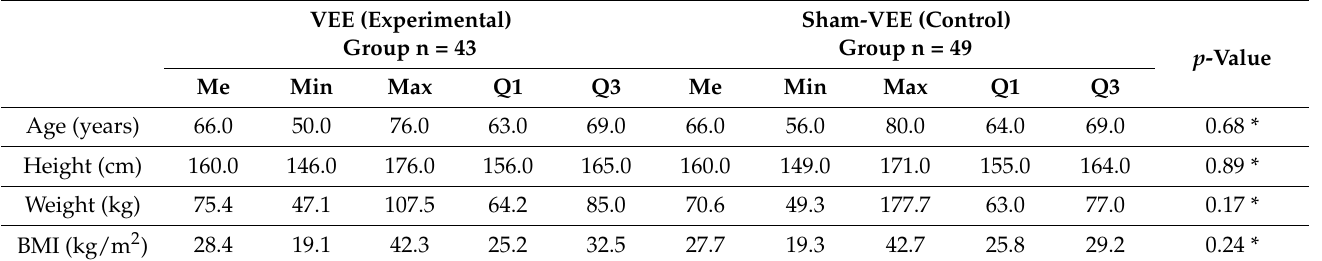
Table 1. Characteristics of the